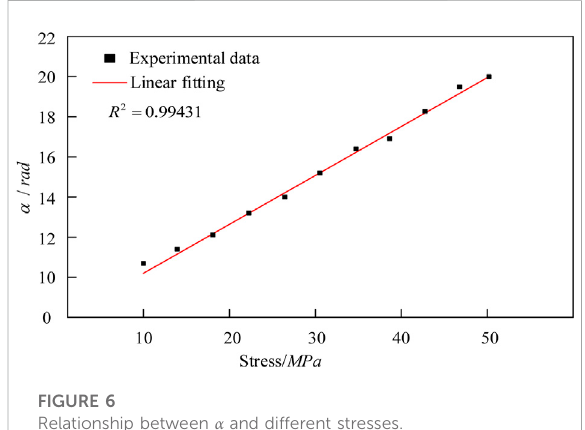
FIGURE 6 Relationship between α and different stresses.